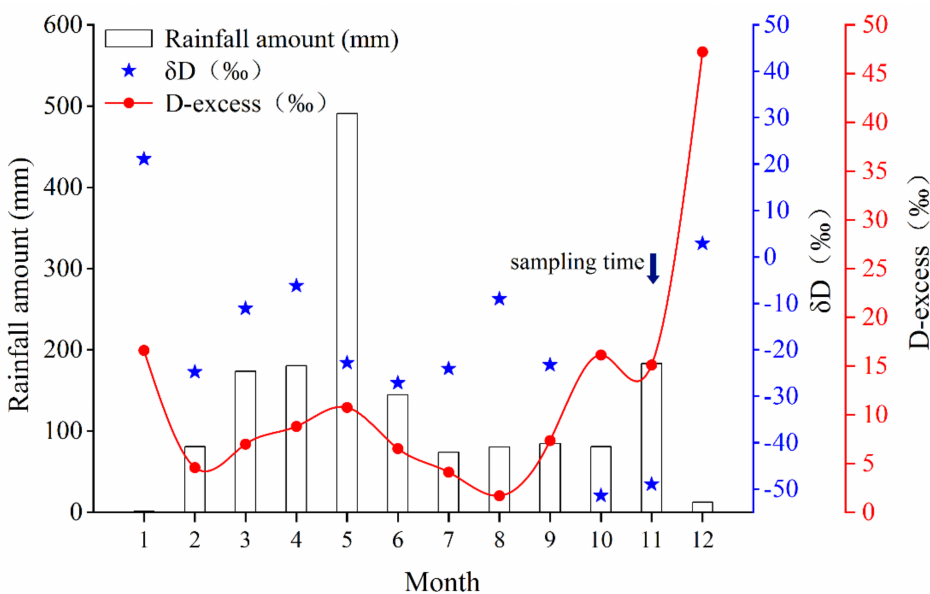
Figure 2. Precipitation distribution and seasonal variation in deuterium surplus in the study area. The ranges of precipitation δ D and δ 18 O were − 79.1‰ to 42.0‰ and − 11.6‰ to 5.1‰, respectively, and the Guilin precipitation line in 2021 was δ D = 7.30 δ 18 O + 7.74 (R 2 = 0.94), where the slope and intercept were smaller than those of the global atmospheric precipitation line ( δ D = 8 δ 18 O + 10) [41] and smaller than the slope and intercept of the atmospheric precipitation line ( δ D = 8.8 δ 18 O + 17.96) in Guilin in 2012 (Figure 3) [42]. The groundwater δ D and δ 18 O varied from − 36.2‰ to − 33.9‰ and − 6.4‰ to − 5.8‰, respectively, and their groundwater points were distributed close to the LMWL, which also proved that precipitation was an important source of groundwater recharge. The fitted curve (GWL) was δ D = 5.27 δ 18 O − 2.45 (R 2 = 0.83), and its intercept and slope were lower than the LMWL.